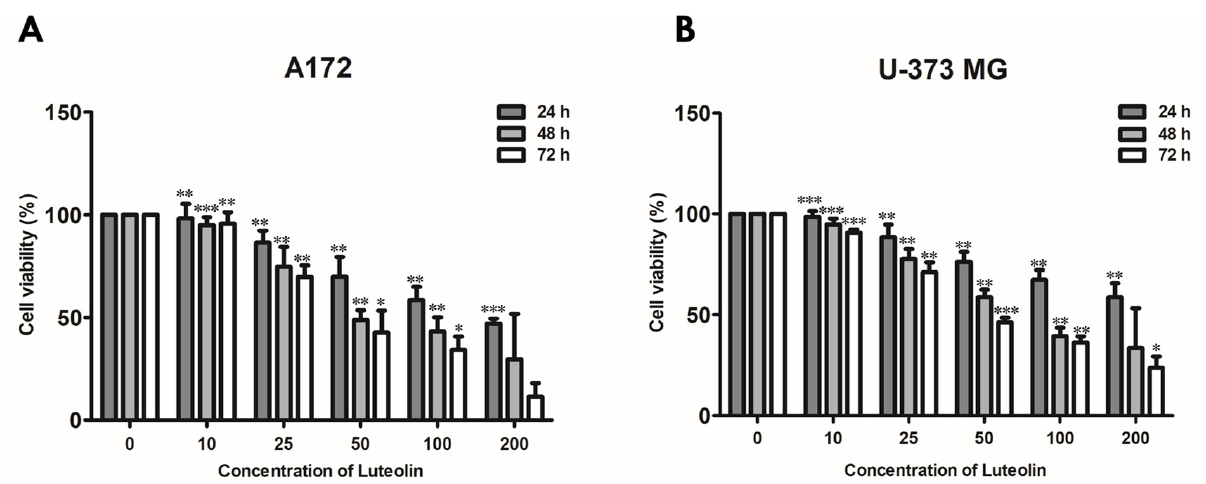
Figure 1. Cell viability of luteolin-treated GBM cells. A172 ( A ) and U-373MG ( B ) cells were treated with different concentrations of luteolin (0–200 µ M) for 24–72 h; cell viability was measured by MTT assay. Results are expressed as mean ± SD (* p < 0.05, ** p < 0.01, and *** p < 0.001).